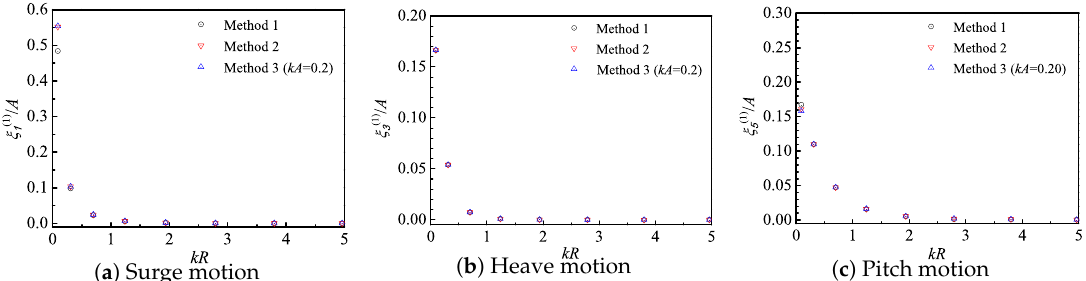
Figure 15. The 1st-order surge, heave and pitch motion RAOs of the 6MW spar-type FOWT by different